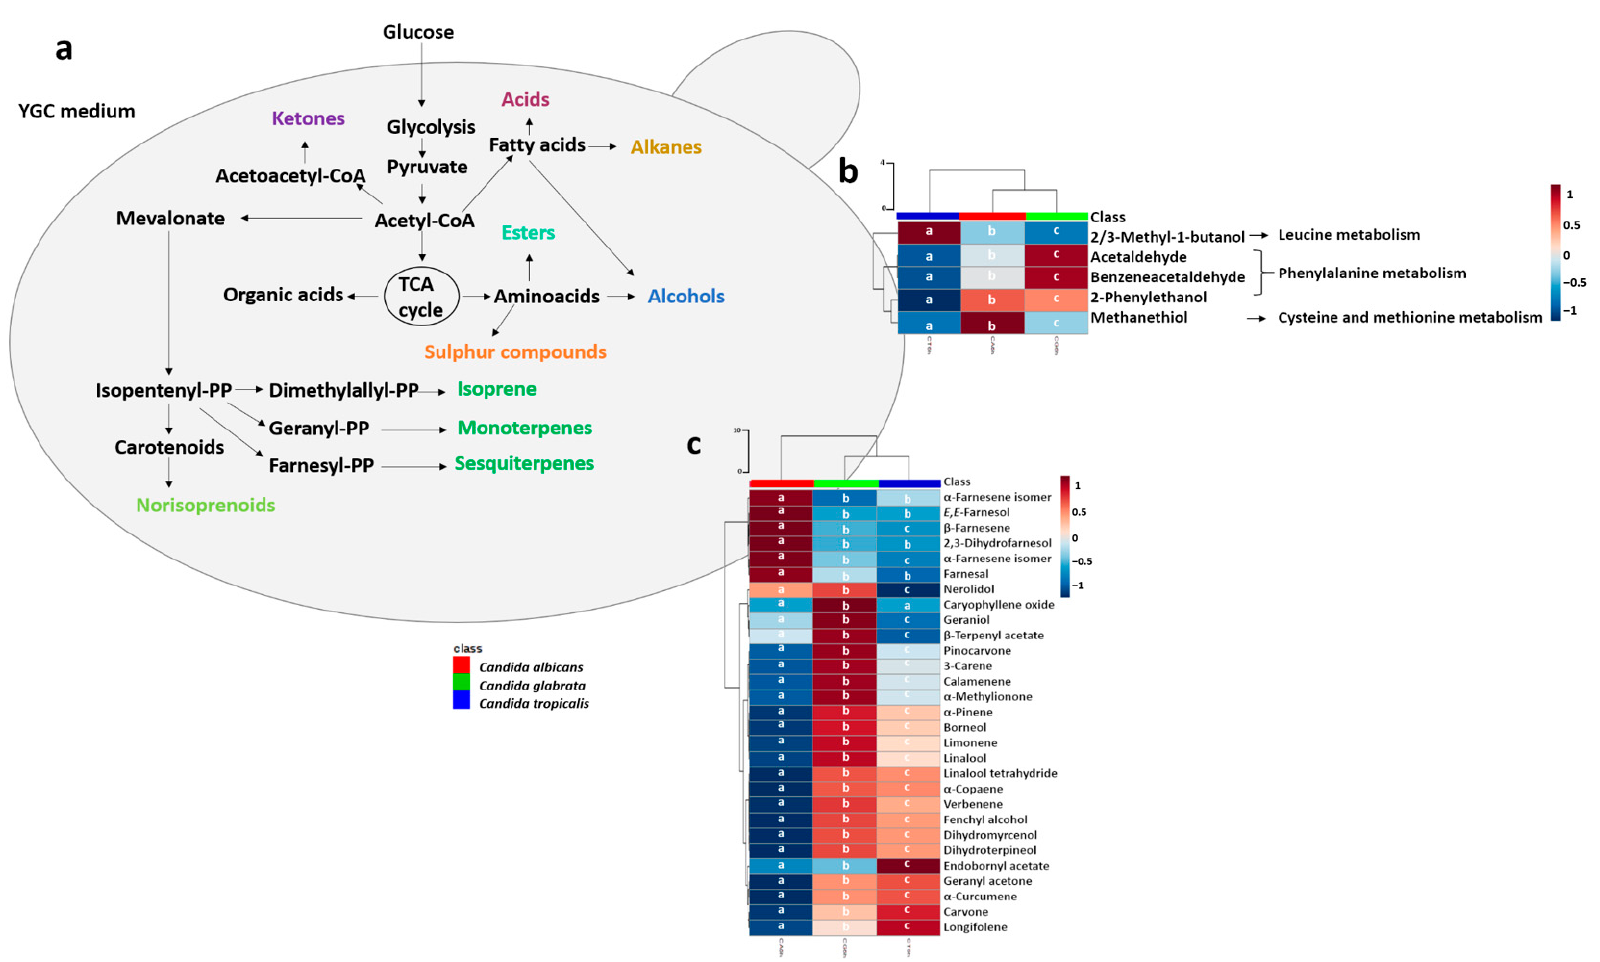
Figure 7. ( a ) Schematic representation proposed to explain Candida species metabolic pathways related to metabolites chemical families [70,71] and heatmap visualization of the metabolites from three strains of Candida species cultures: Candida albicans , Candida glabrata and Candida tropicalis at 6 h of growth time. ( b ) Amino acid metabolism related analytes; ( c ) Terpen-secondary metabolites [75]; Di ff erences corresponding to p < 0.05 were considered significant and were marked with a, b and